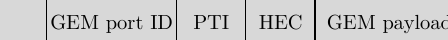
Figure 2. Structure of GEM frame.